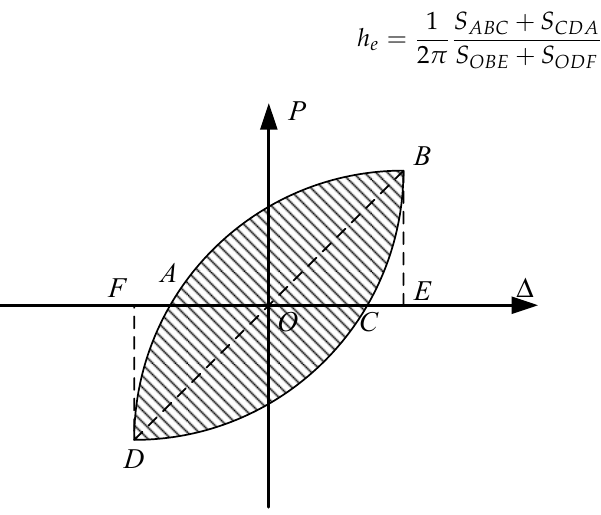
Figure 14. A schematic diagram of the calculation of equivalent viscosity coefficient.